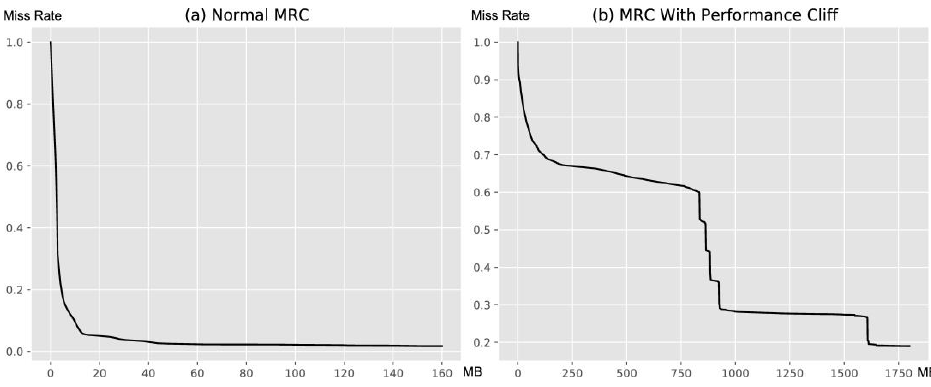
Figure 1. The example of MRC in multi-cache storage system.